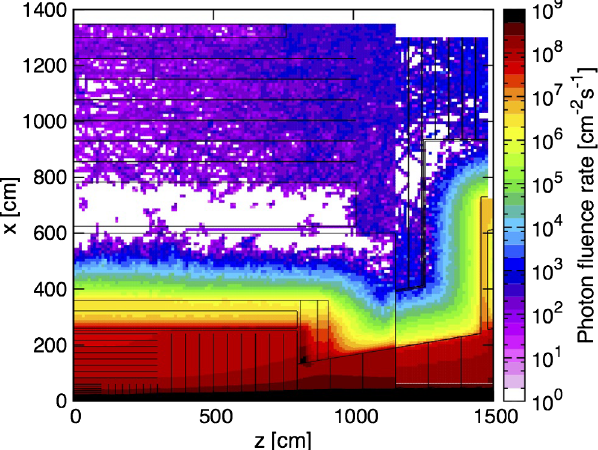
15. Photon fluence rate for an instantaneous luminosity of 30 × 10 34 cm − 2 s − 1 in the presence of the shielding described in the text: top view, zoom on the muon chambers. In the central region ( z < 10 . 5 m) values are azimuthally averaged over 120 degrees around 0. In the forward region an average in the vertical direction around y ¼ 0 is done on a bin of about 4.1 m (for j x j > 0 . 6